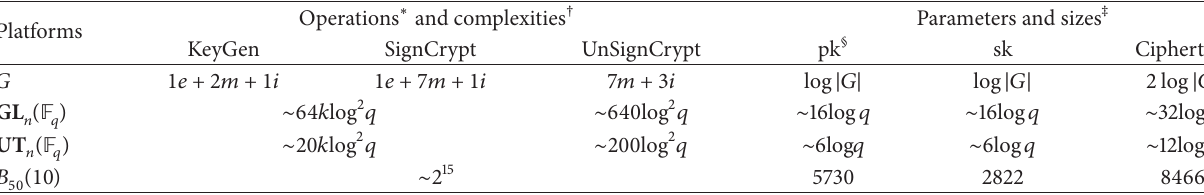
Table 1: Performance of signcryption scheme 𝑉 3 ( 𝑛 = 4